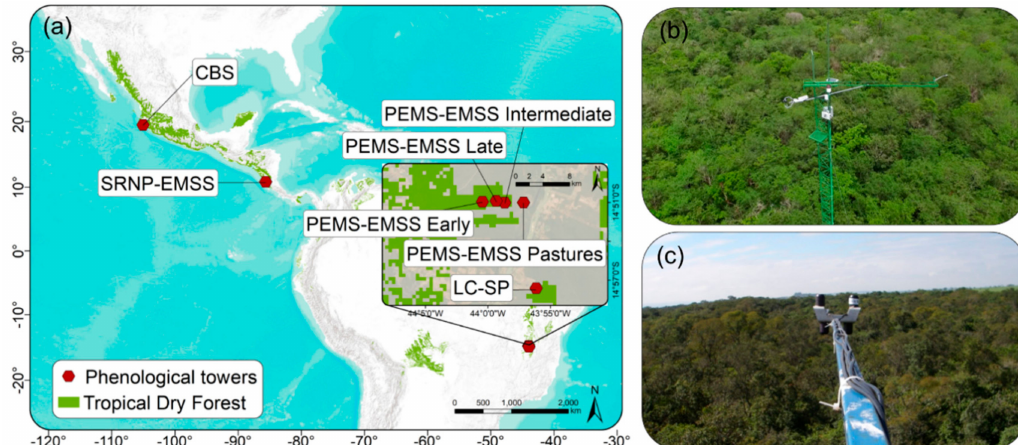
Figure 1. Location map of the optical phenological towers at four tropical dry forests distributed along the Americas ( a ) and images of the towers ( b ) and sensors used ( c ). Chamela Biological Station